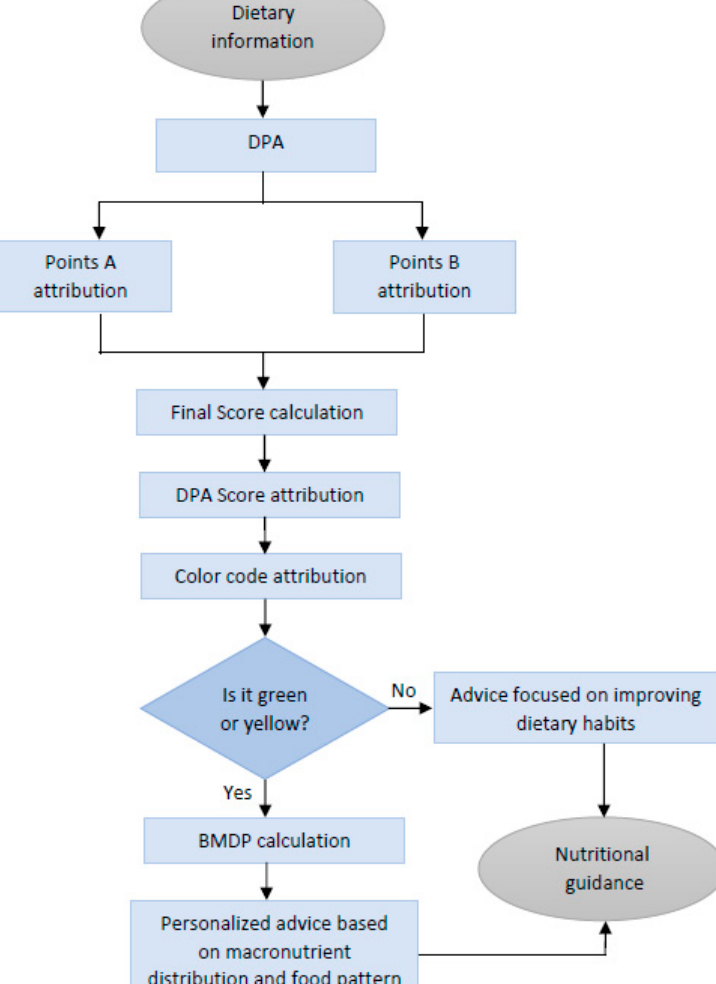
Figure 2. Flow chart of the DPA, a diet profiling algorithm to assess diet quality. Nutritional information is processed by the algorithm, taking into consideration the constraints fixed. Dietary records are used as input data to ultimately result in nutritional guidance at different levels of personalization. Abbreviations: DPA (diet profiling algorithm); BMDP: balanced macronutrient distribution parameter.